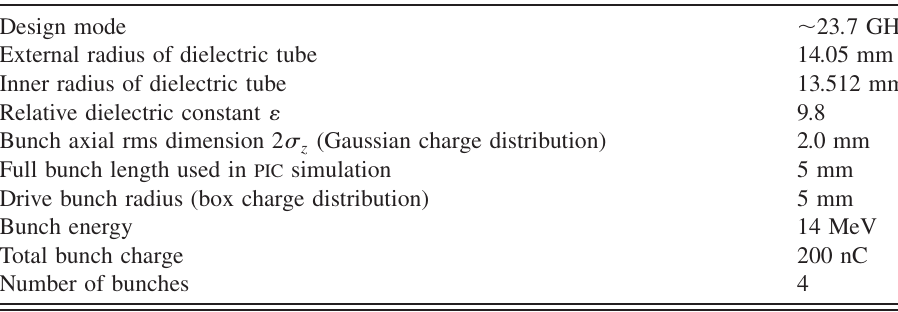
TABLE II. Parameters used for study of a cylindrical dielectric-lined collinear